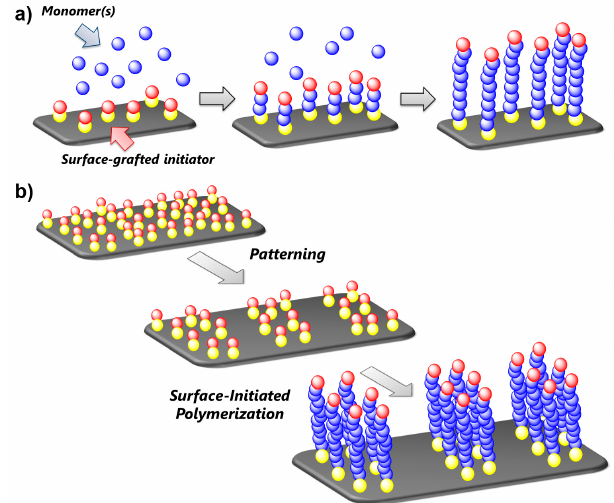
Figure 3. Schematic representation of ( a ) polymer brushes obtained by surface-initiated polymerization and ( b ) the process to obtain patterned polymer brushes. The yellow spheres represent a surface-anchoring functional group for the initiator (red spheres) and the blue spheres the monomer(s). If the polymerization is controlled, the polymer chains are capped with an initiation site.